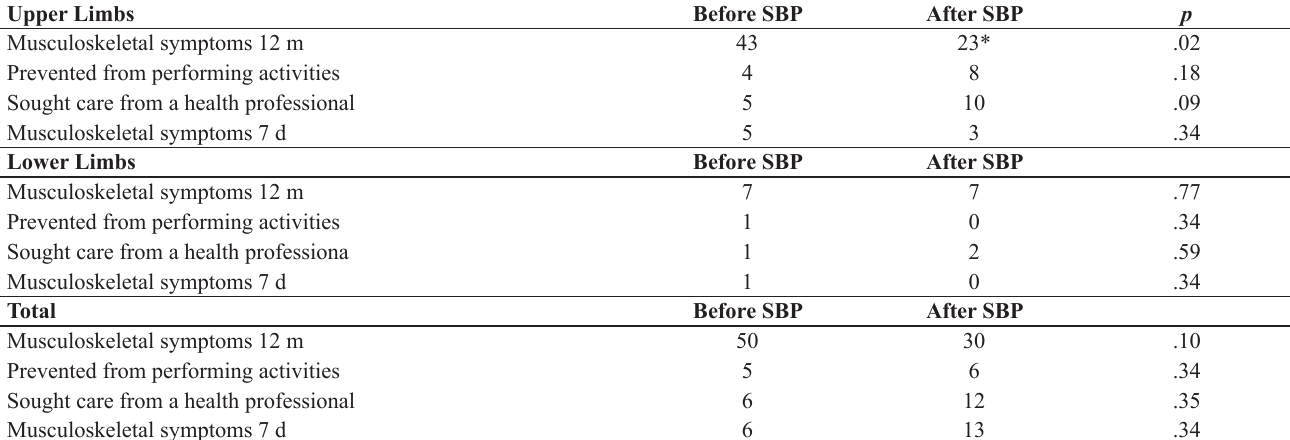
Table 4. Number of musculoskeletal symptoms reported by the AW before and after the 6-month stretch break program. Upper